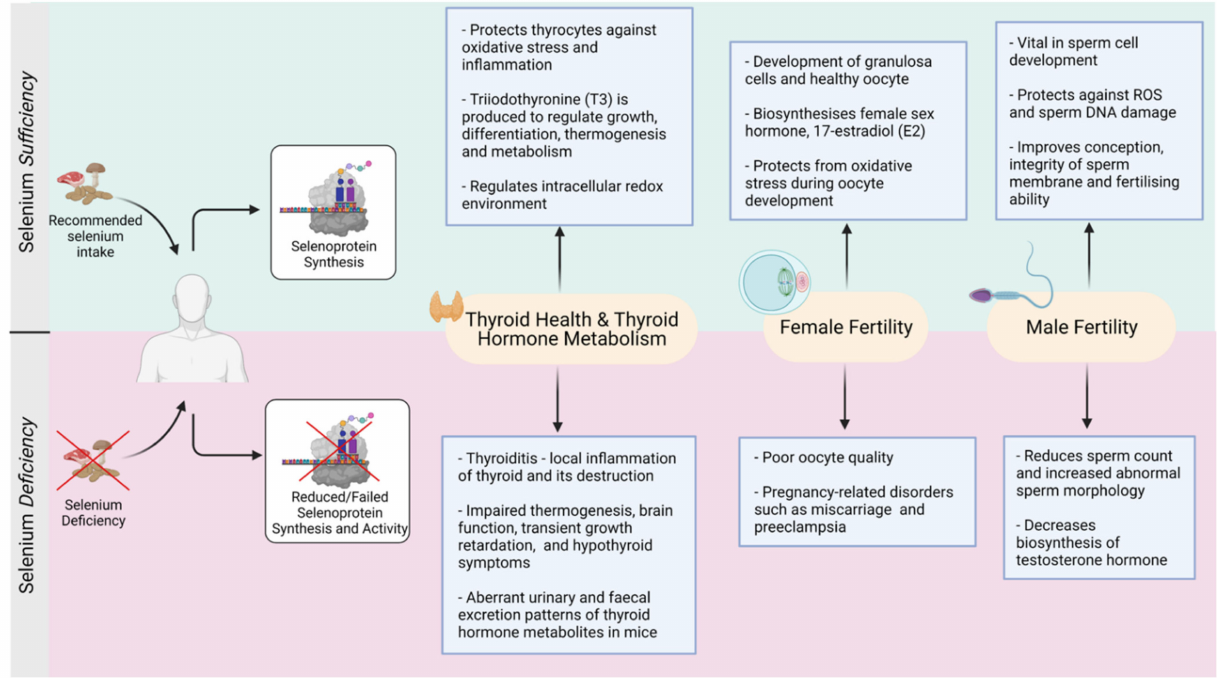
Figure 3. Selenium-mediated balance and imbalance in the thyroid and reproductive functions (Created with BioRender.com, accessed on